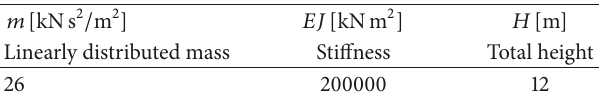
Table 15: Geometric parameters of the undamaged bending moment-deflecting cantilever beam.